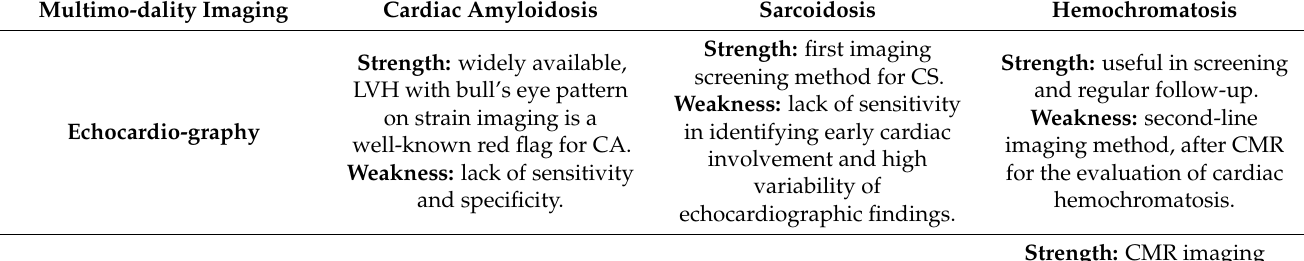
Table 1. Strength and weakness of each imaging modality in the diagnosis and management of patients with infiltrative cardiomyopathies. Multimo-dality Imaging